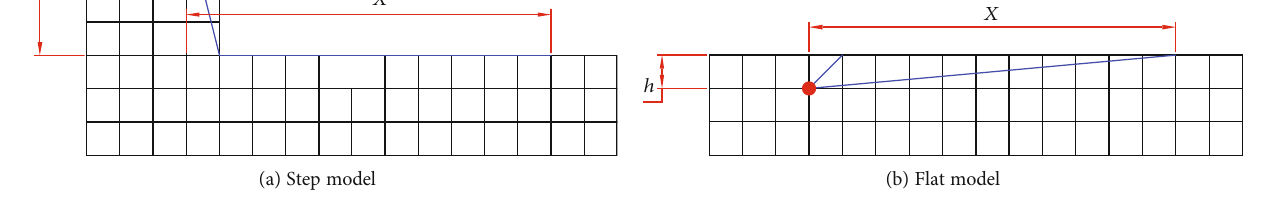
Figure 2: Elastic wave propagation